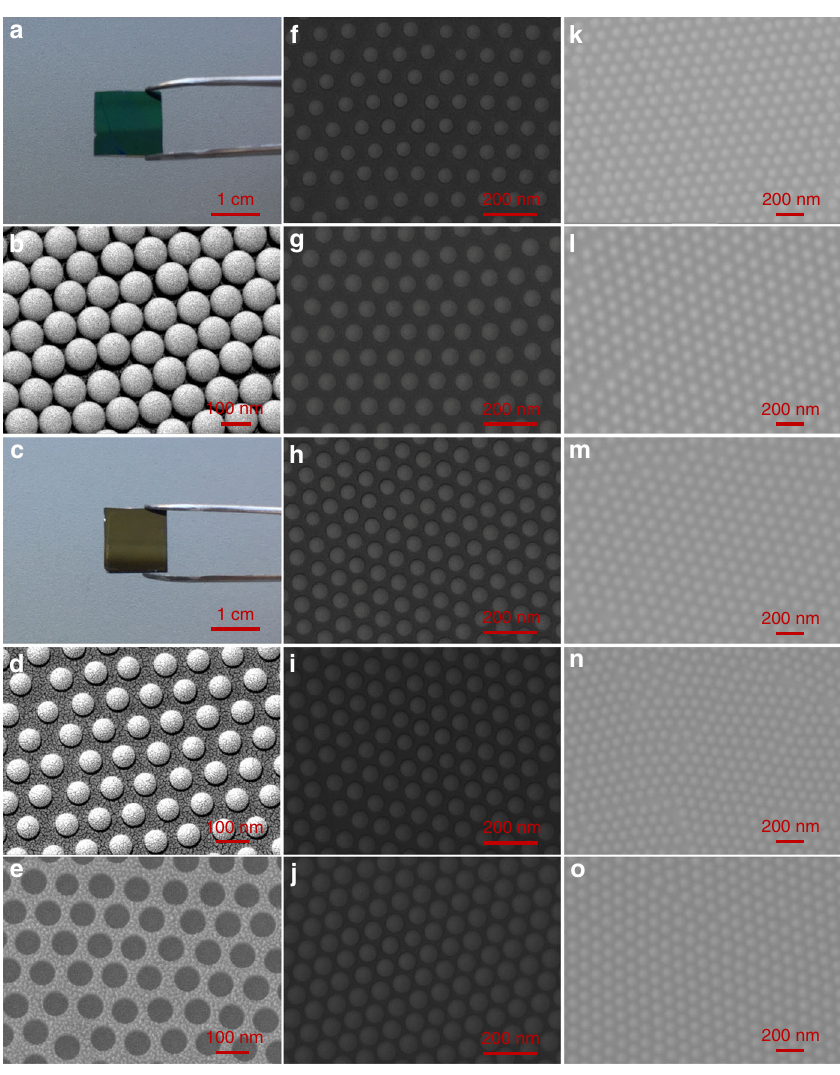
Fig. 2 Morphological characterizations. a Digital photo of closely packed monolayer PS nanospheres with diameter of 100 nm on SiO 2 /Si substrate. b Scanning electron microscopy (SEM) image of closely packed monolayer PS nanospheres with diameter of 100 nm. c Digital photo of PS nanospheres on SiO 2 /Si substrate after etching for 22 s. d SEM image of PS nanospheres after etching for 22 s. e SEM image of prepared nanohole arrays template. f − j SEM images of Bi 2 Te 3 nanoparticle arrays prepared by using 100 nm PS nanospheres as patterns. k − o SEM images of PEDOT/Bi 2 Te 3 (100) hybrid fi